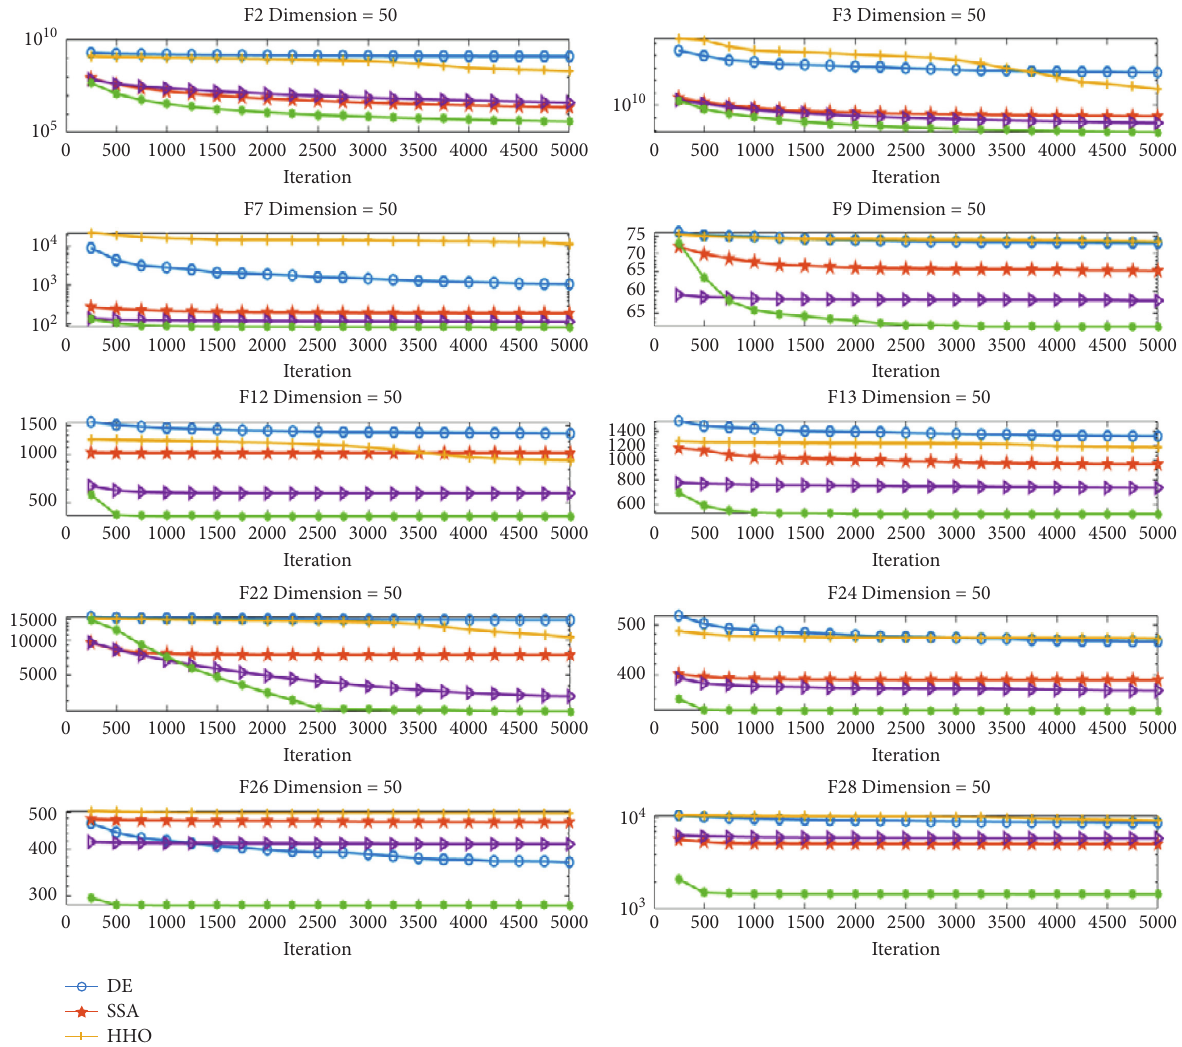
Figure 6: APPE’s convergence curve with the dimension of